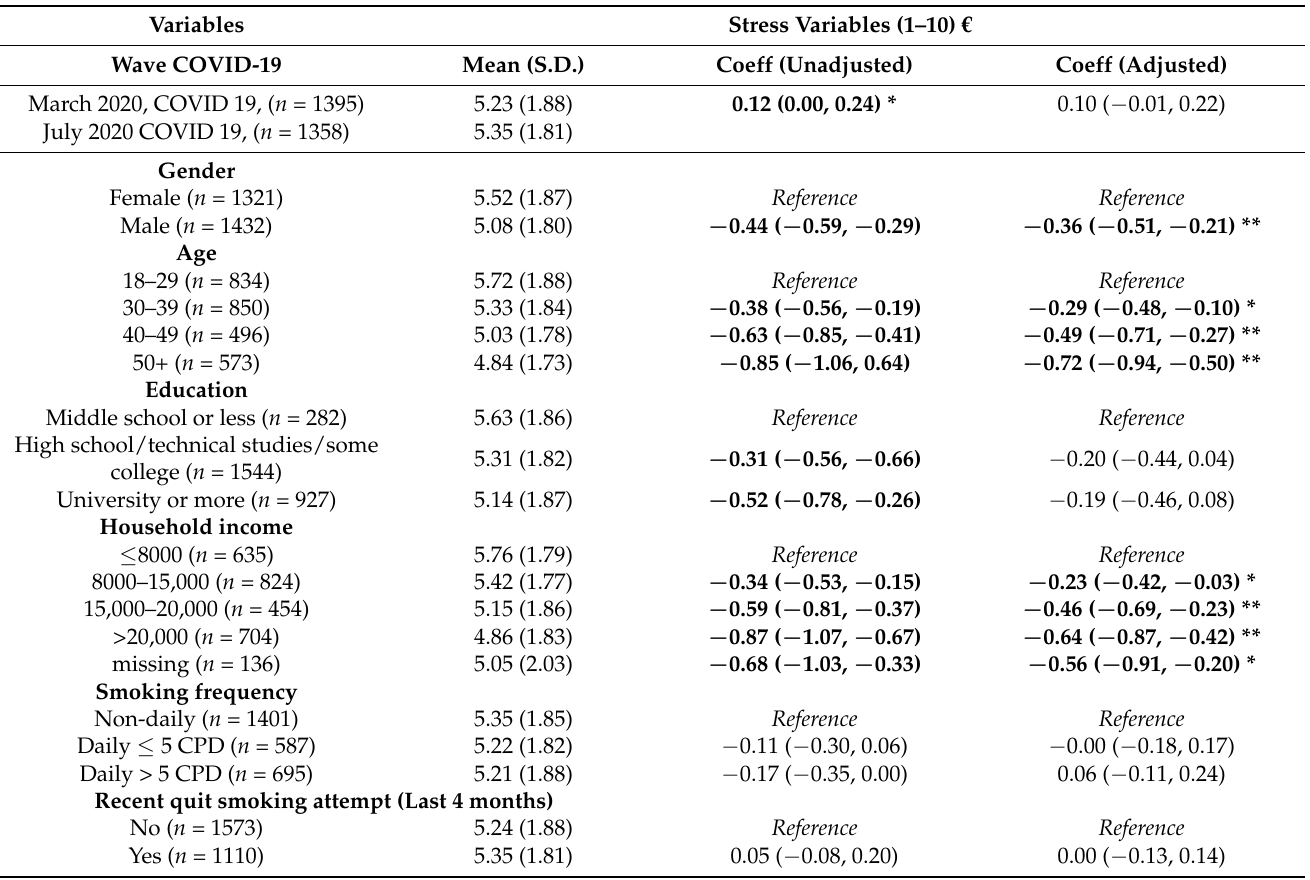
Table 3. Scale of stress during the COVID-19 pandemic among Mexican smokers and dual users, 2020 ( n = 2753).